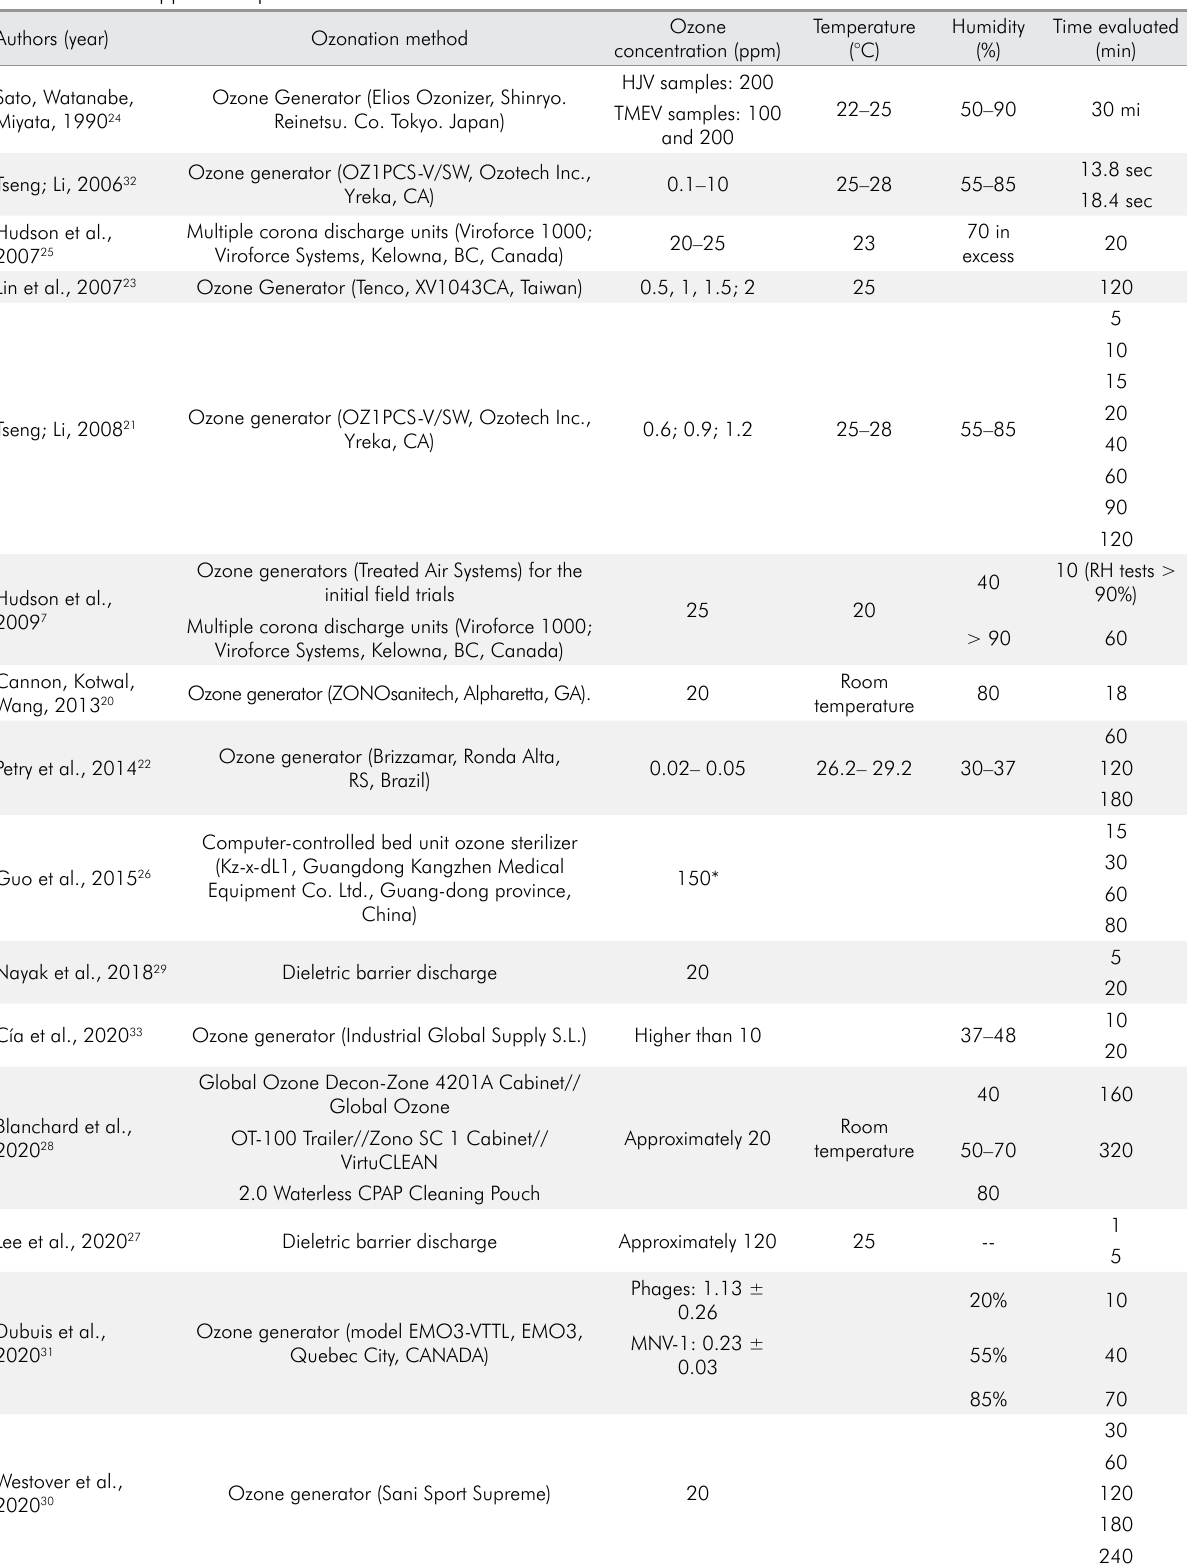
Table 3. Ozone application